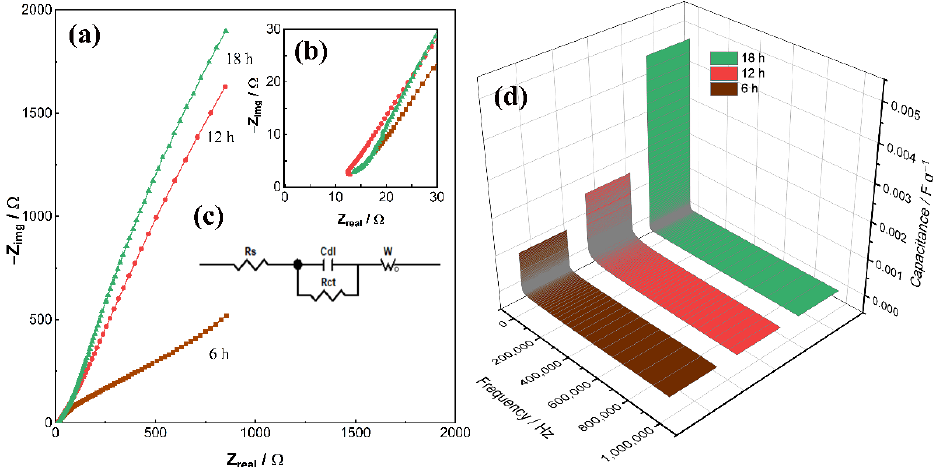
Figure 13. ( a ) Electrochemical impedance spectroscopy of ZnMn 2 O 4 samples prepared for 6 h, 12 h, and 18 h with ( b ) the zoom on the Nyquist plots for the high-frequency region and ( c ) the equivalent circuit model. ( d ) Variation of the specific double-layer capacitance of ZnMn 2 O 4 samples as a function of frequency.